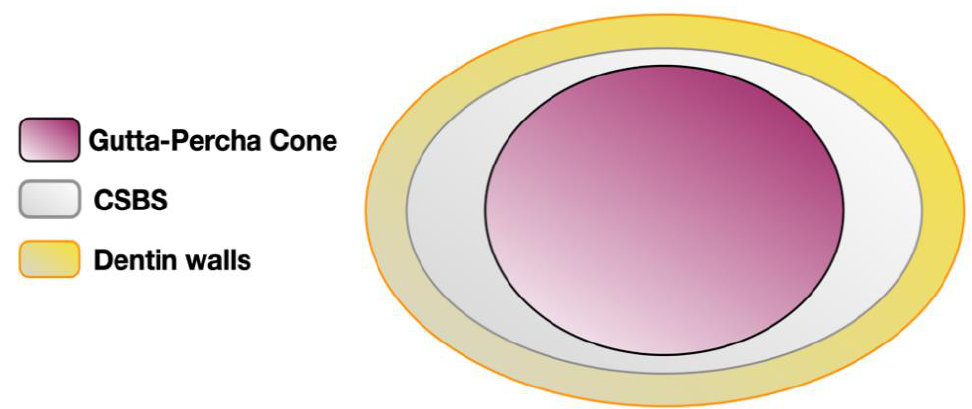
Figure 2. Updated single-cone technique with CSBS (sealer-based obturation) considering their enhanced dimensional stability.